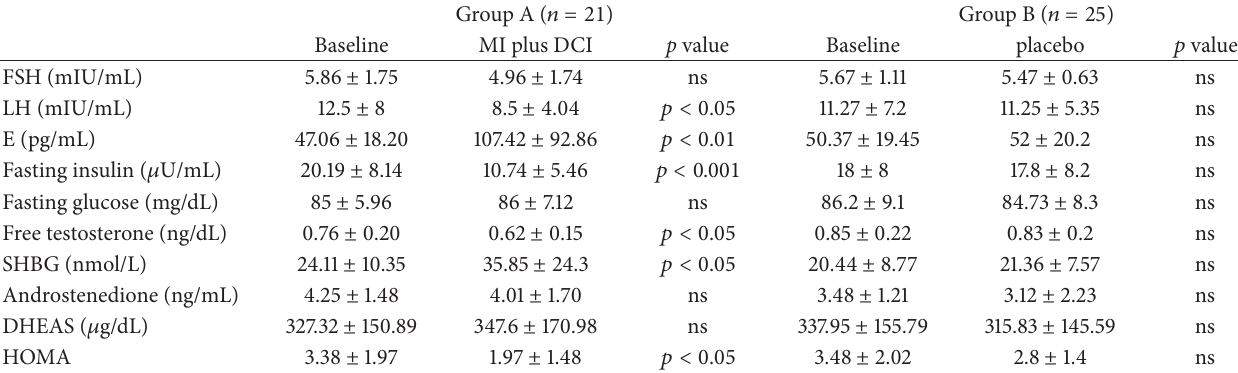
Table 2: Baseline and posttreatment endocrine and metabolic parameters of groups A and B of PCOS